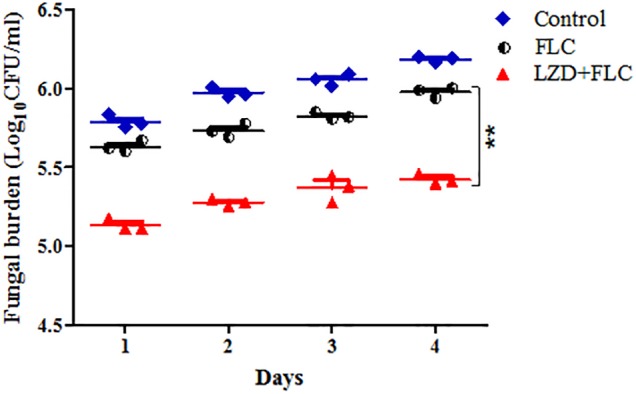
Fungal burden of infected G. mellonella larvae treated with different drugs. CA10 (5 × 108 CFU/mL) was used to infect the G. mellonella larvae (20 larvae for each group). After infection, the larvae were treated with sterile PBS, FLC (160 μg/mL), LZD (200 μg/mL), and LZD (200 μg/mL) plus FLC (160 μg/mL), respectively and incubated. Three larvae from each group were randomly selected daily and were homogenized to determine C. albicans burden by inoculating dilutions of the homogenized larvae onto YPD solid medium plates as described above. For clarity, the fungal burden of the LZD group is not shown because the data were similar to that of the control group. The data came from the means of three independent experiments, and Student’s t-test was performed. Compared with the FLC-treated group, ∗∗P < 0.01.